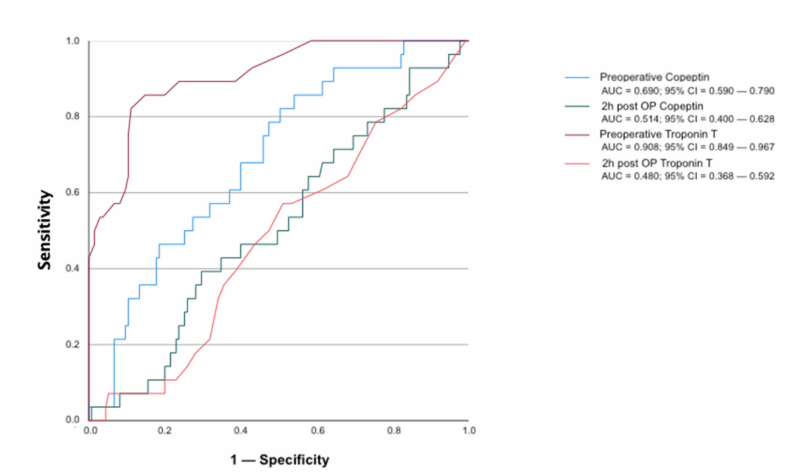
Figure A2. Receiver–operator characteristic curves for MINS and Copeptin concentrations at baseline (blue) and within two hours after surgery (green) and Troponin T concentrations at baseline (red) and within two hours after surgery (orange). 2 h post OP, within two hours after surgery; AUC, area under the curve; CI, confidence